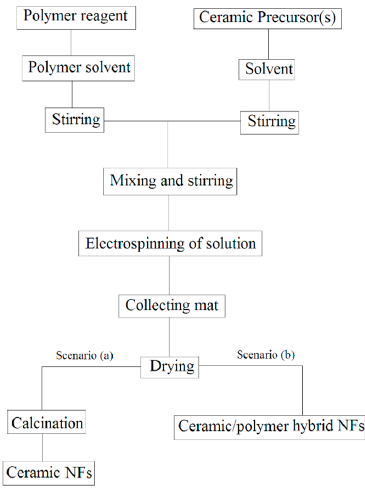
Figure 3. Flowchart of ceramic and ceramic/polymer NFs fabrication via electrospinning method.